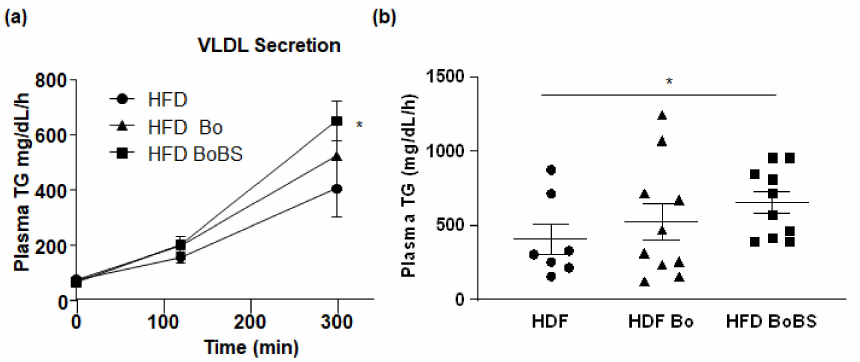
Figure 3. Effect of diet and carrot supplementation on very low-density-lipoprotein (VLDL) TG secretion after Triton WR-1339 injection ( a ), VLDL TG secretion rate assessed 3 h after lipoprotein lipase inhibition by Triton WR-1339 injection ( b ) in mice receiving HFD (black circle, n = 7, samples from 7 males), or HFD containing Bolero under standard condition (HFD Bo; black triangle, n = 10, samples from 10 males) or Bolero under biotic stress condition (HFD BoBS, black square, n = 10, samples from 10 males) for 14 weeks. Data were given as mean ± SEM. * p < 0.05 vs., HFD